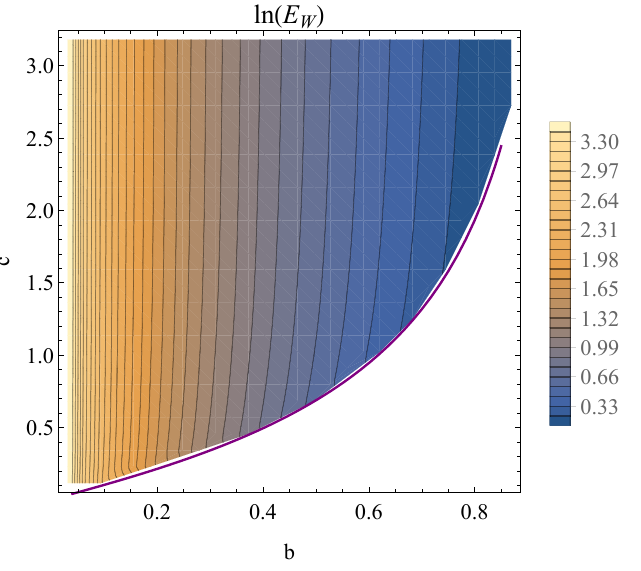
Figure 8 . The contour plot of ln E ( b, c ) over ( b, c ) space. The purple curve corresponds to the W critical line of non-zero MI from the right plot of figure